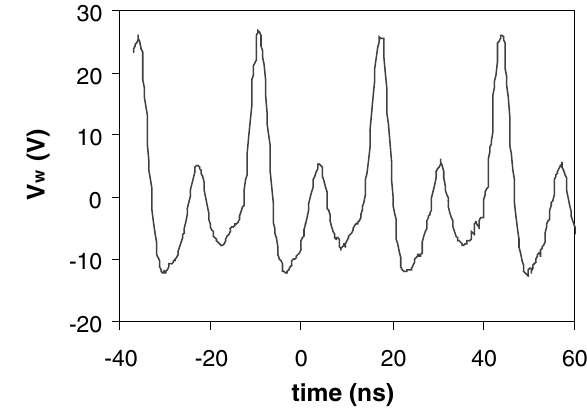
y = 226.37x R 2 = 0.9987